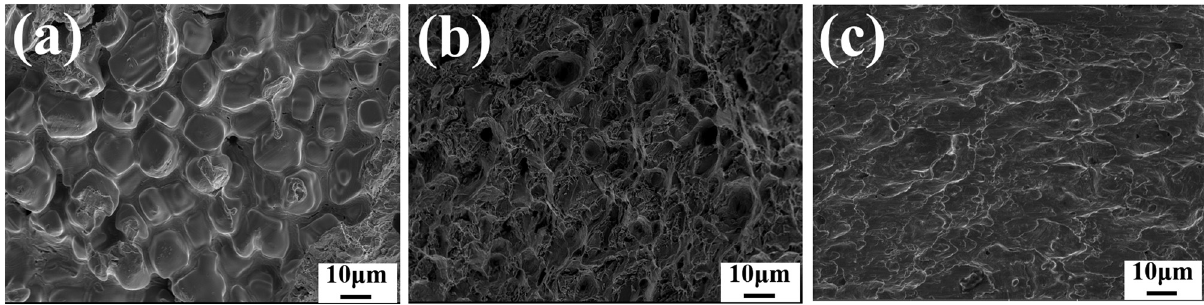
Figure 14: Fracture morphology of the joints at ( a ) 0%; ( b ) 2%; and ( c )